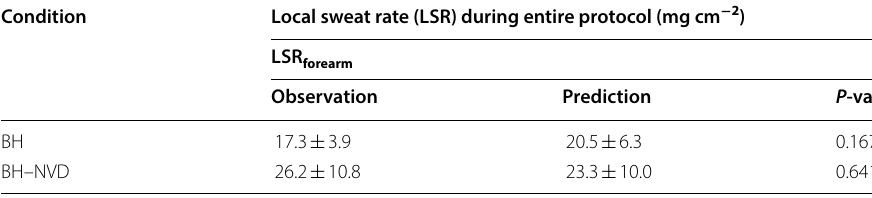
Prediction of LSR upper back was conducted based on measured LSR forearm and the ratio of sudomotor sensitivity of the forearm and upper back. In this way, prediction of LSR forearm was based on the measured LSR upper back . Regional sudomotor sensitivity was brought from Smith and Havenith